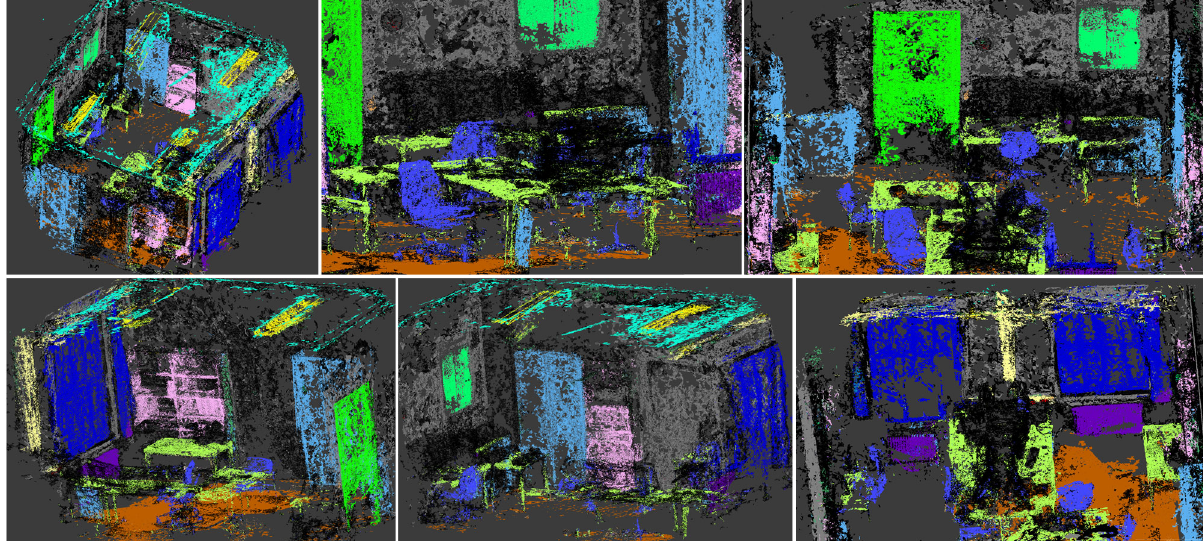
Figure 6. Different views of the post-processed final point cloud. Rotation and scale are corrected. Extracted wall point are visible in the point cloud in light grey